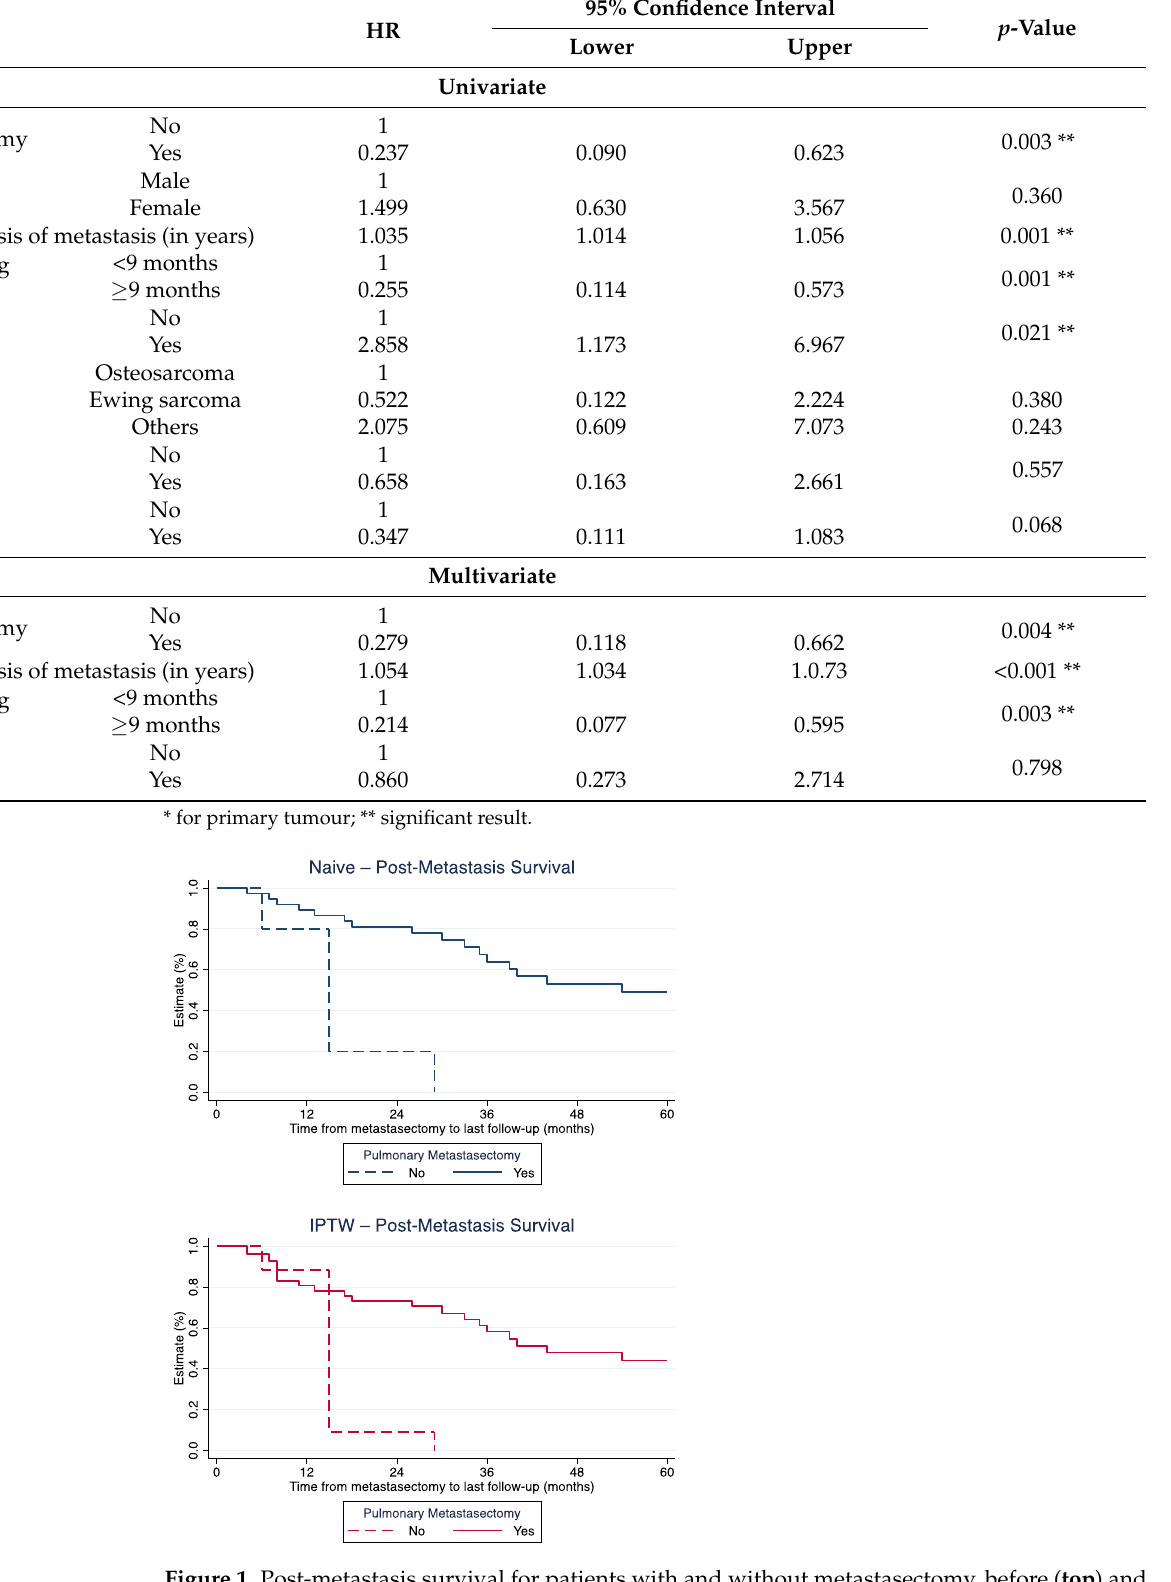
Table 2. Univariate and multivariate IPTW-weighted Cox-regression models for post metastasis survival. 95% Confidence Interval HR Lower Upper Univariate